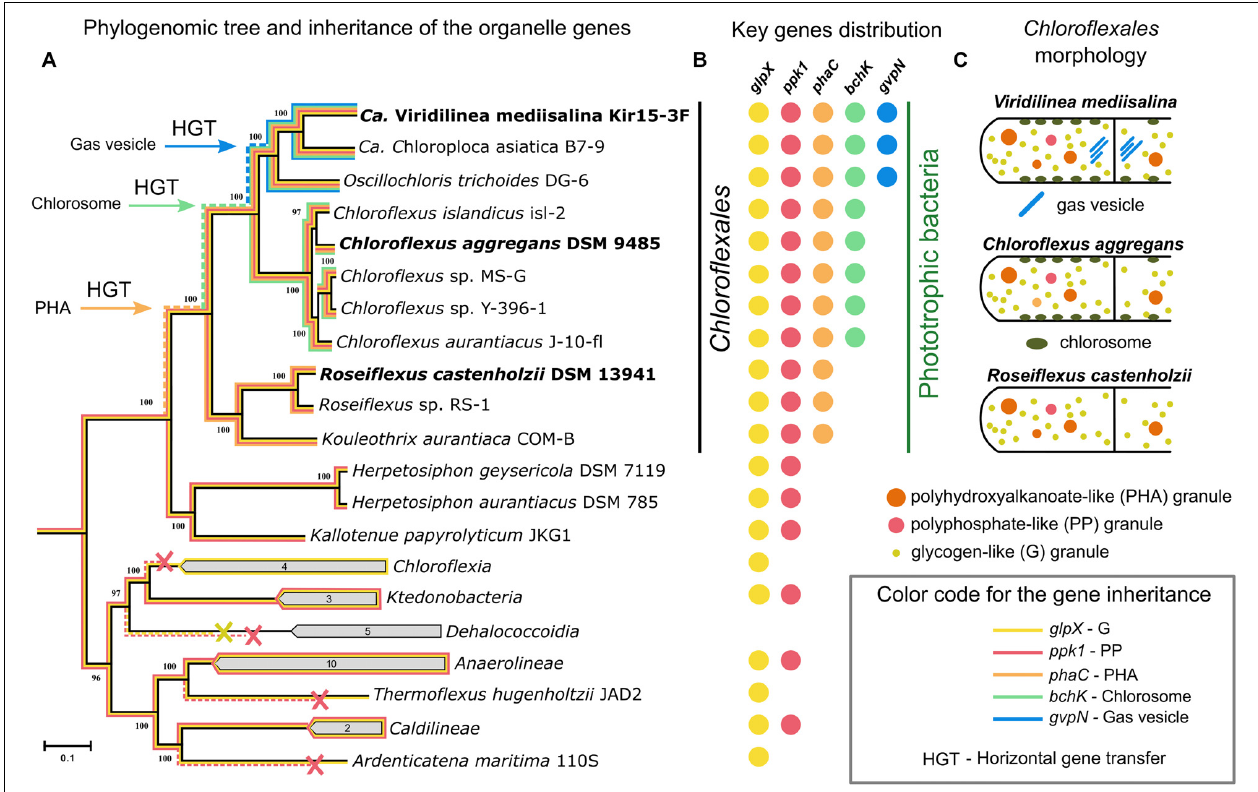
FIGURE 5 | Maximum-likelihood phylogenetic tree (black line) inferred from concatenated alignment of 120 single-copy phylogenetic marker (GTDB dataset) genes (A) . List of genomes included in the phylogenetic analysis was presented in Supplementary Table S1 . Distribution of g lpX , ppk1 , phaC , bchK , and gvpN genes that encode the proteins for biogenesis of the intracellular bodies across Chloroflexota phylum (B) . Inheritance of the key genes is shown on the phylogenetic tree (colored lines). The dashed colored lines denote hypothetical inheritance from common ancestor of a clade. Schematic illustration of the main Chloroflexales morphotypes (C) .